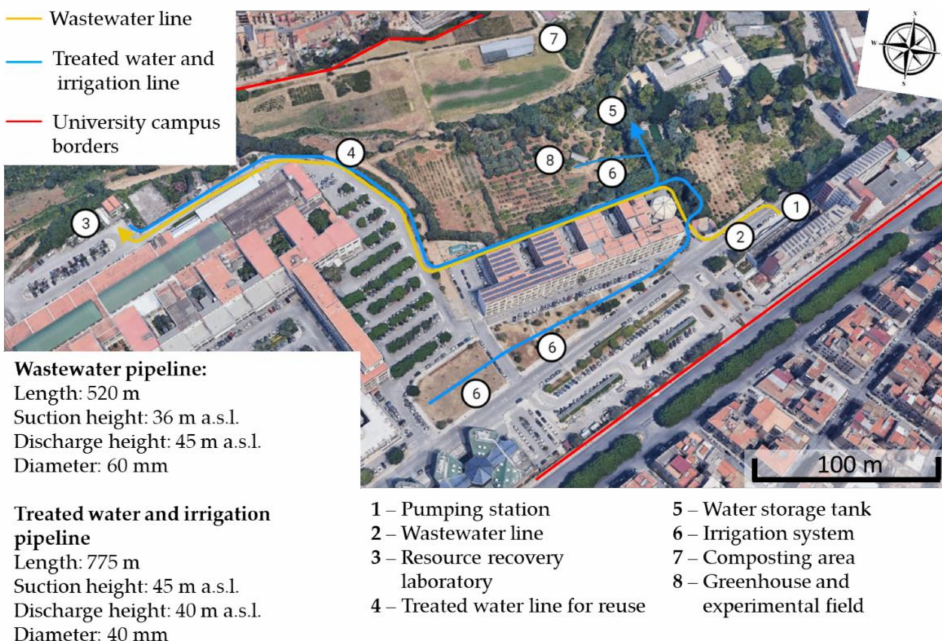
Figure 1. Satellite photo of the University Campus with an indication of the points of interest and the specifications for the wastewater and treated water transport pipelines.